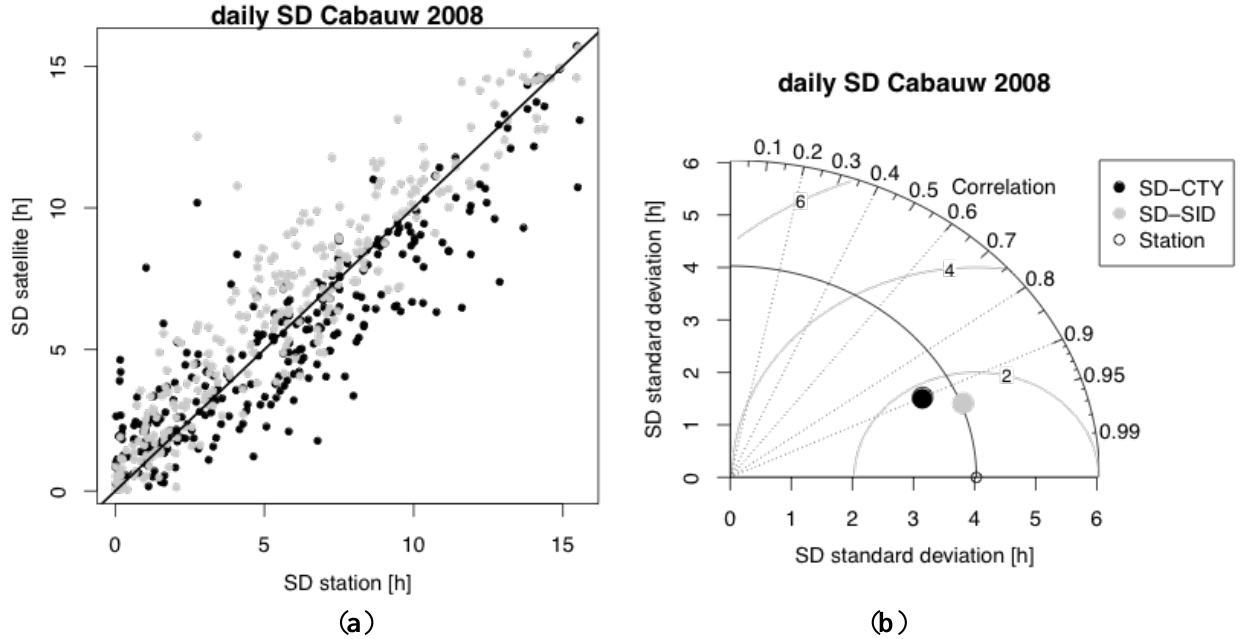
Figure 5. Comparison of daily SD data for SD-CTY and SD-SID with station data for Cabauw (year 2008). The grey circles in the Taylor diagram indicate the root mean square